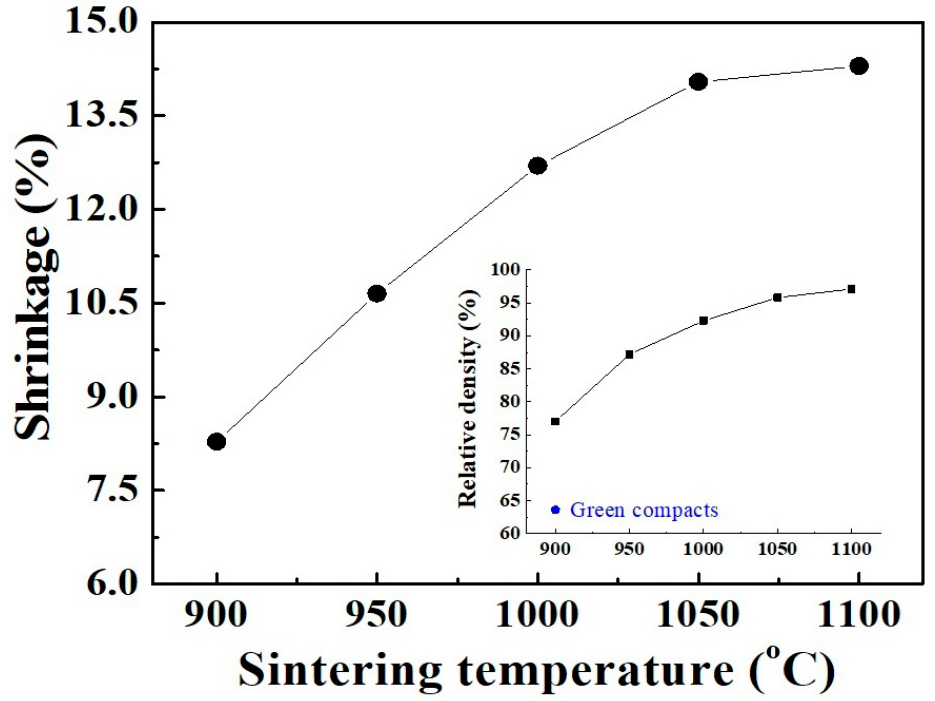
Figure 6. Shrinkage of ceramic pellets, examined as a function of the sintering temperature. The inset shows the relative density (RD) of the ceramics.